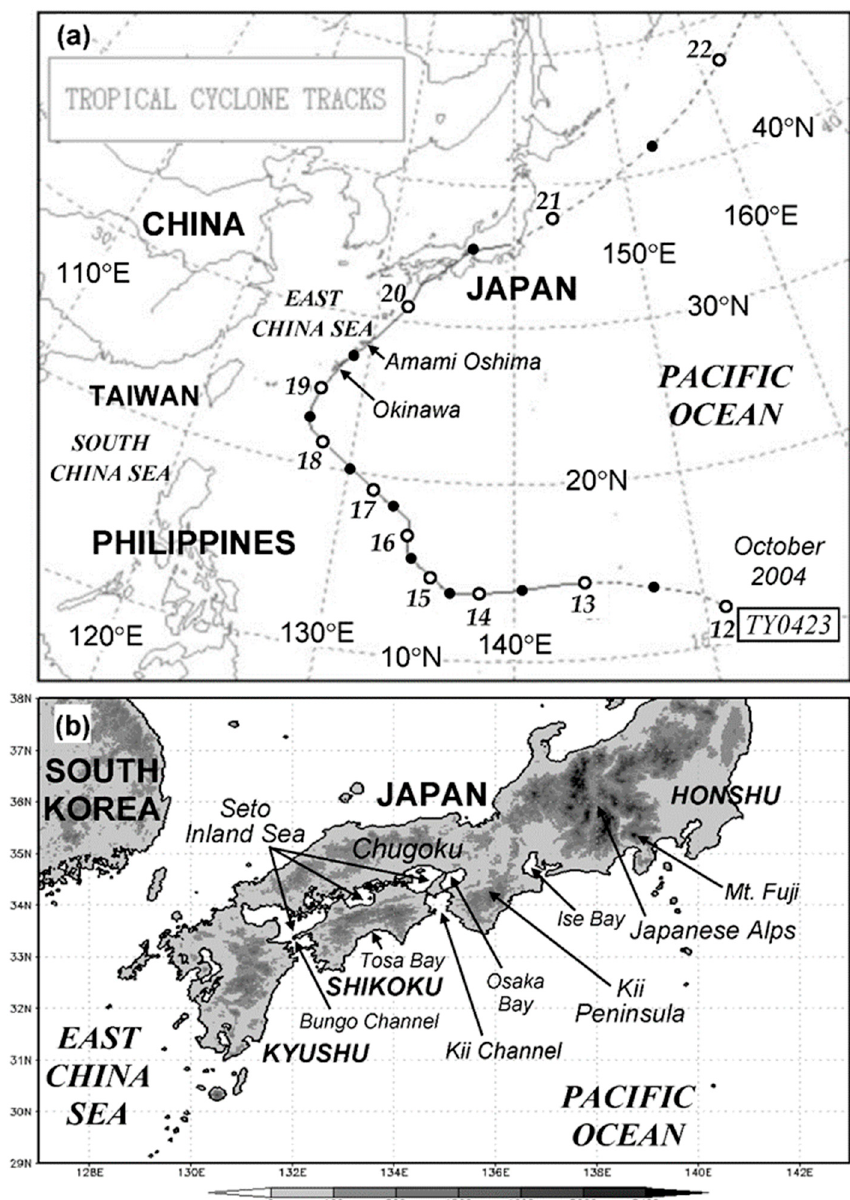
Figure 1. ( a ) The JMA’s best-track data of Typhoon Tokage (TY0423) in UTC during 12–22 October 2004 and ( b ) the focused area of western Japan in this study and its topography (m, gray shades), with various geographical features labelled. In ( a ), open (solid) circles depict the typhoon center at 0000 (1200) UTC of each day, and the solid track indicates the period when the storm reached TC intensity (32.7 m s − 1 ).